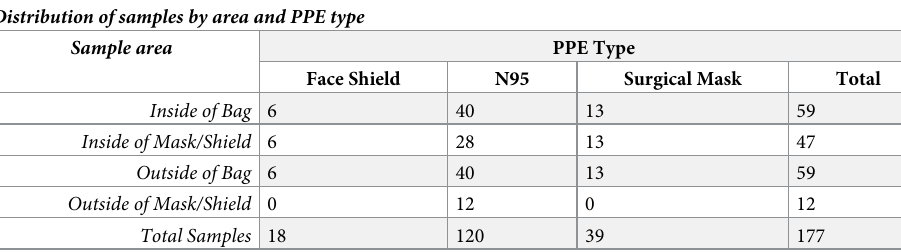
Table 1. Samples by area swabbed and personal protective equipment (PPE) type.